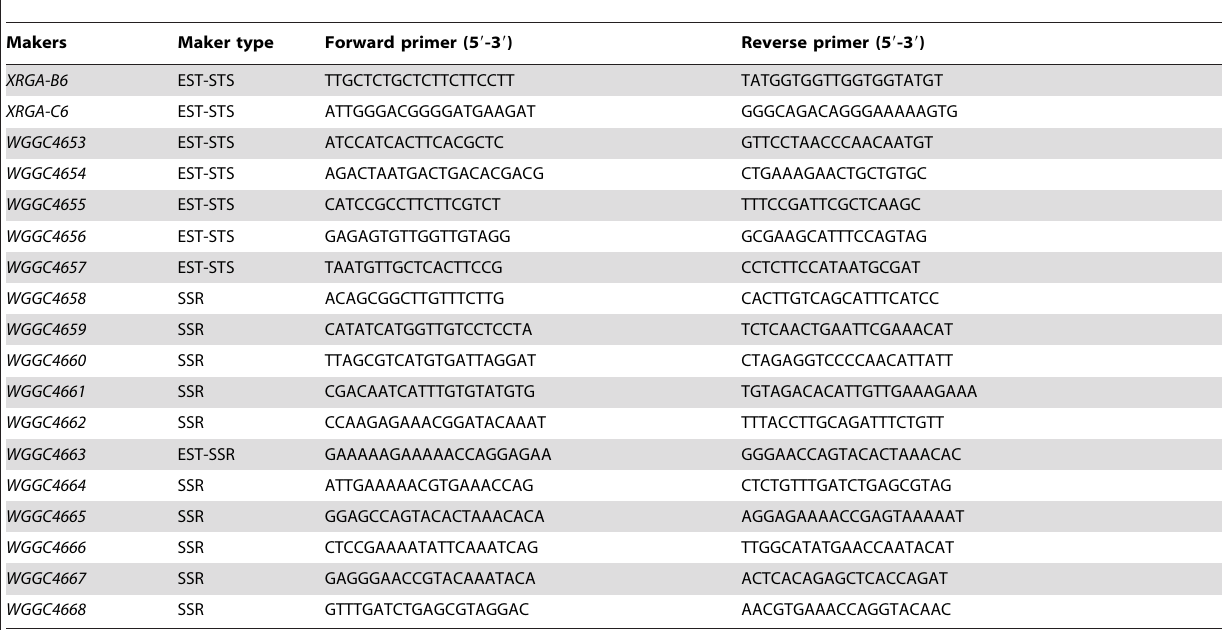
Table 2. EST-STS, EST-SSR and SSR markers linked to powdery mildew resistance gene MlIW172